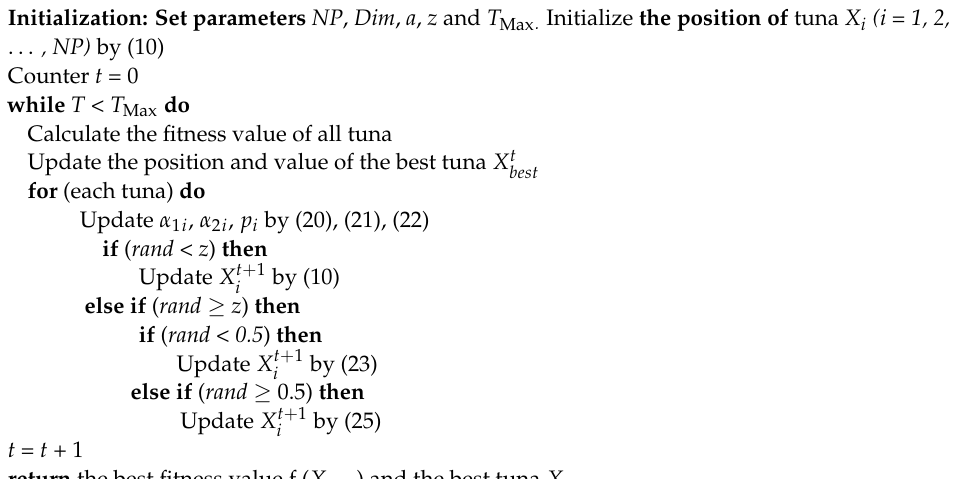
Algorithm 2 Pseudocode of CLTSO